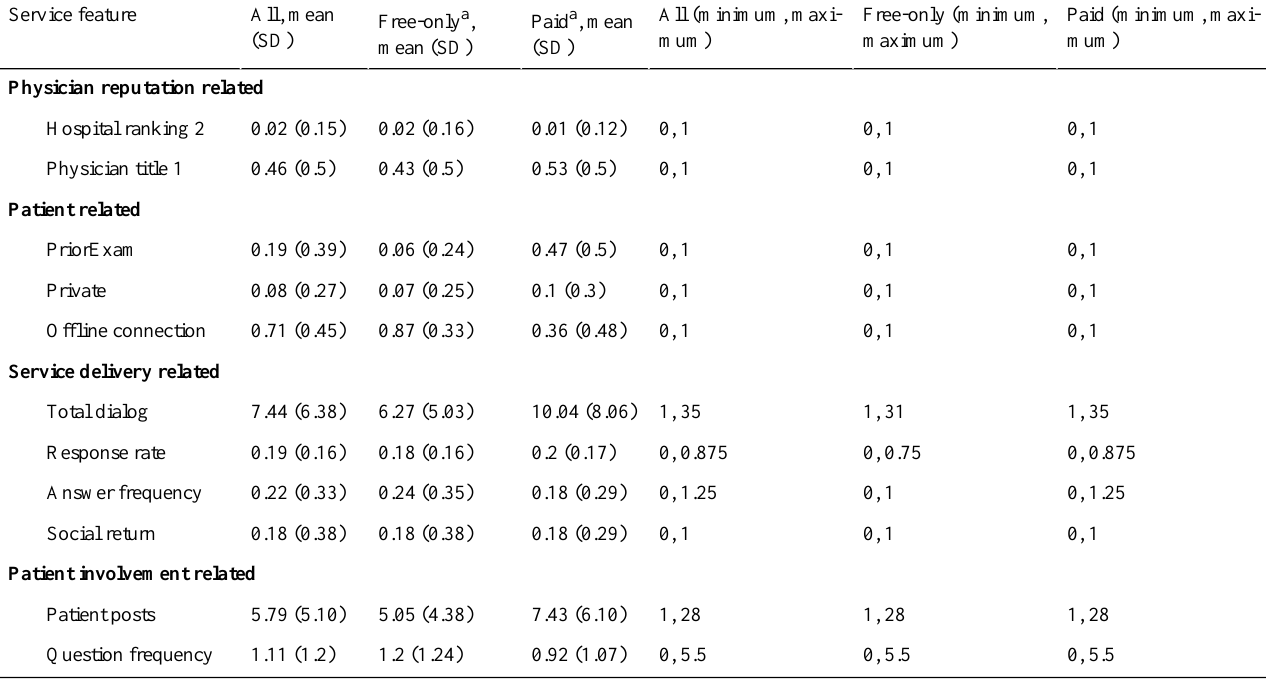
Table 2. Summary statistics of features.